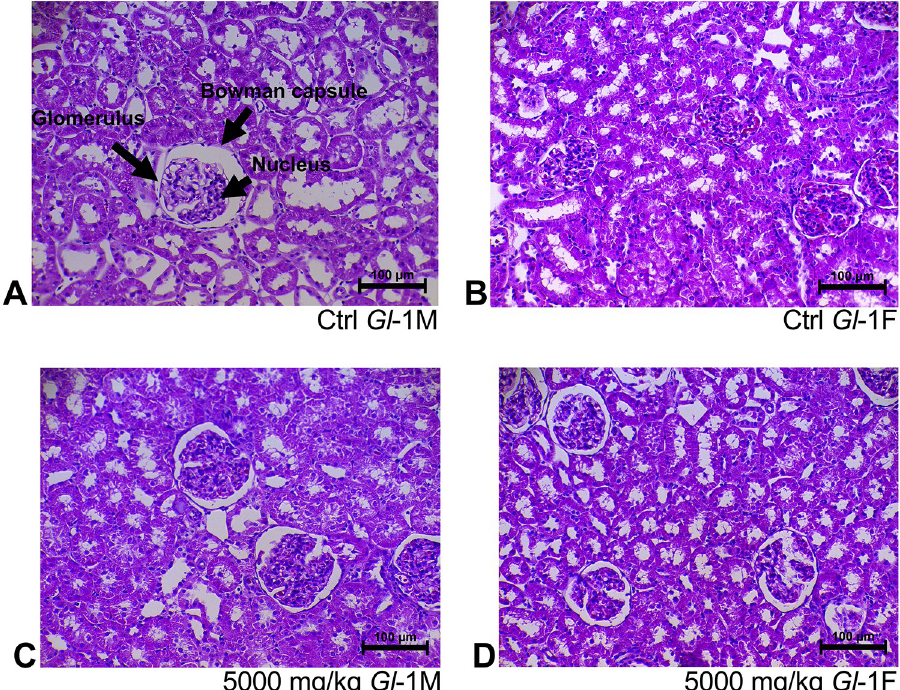
Control (Ctrl) groups. C–D: Treated groups consuming the 5000 mg/kg bw/day